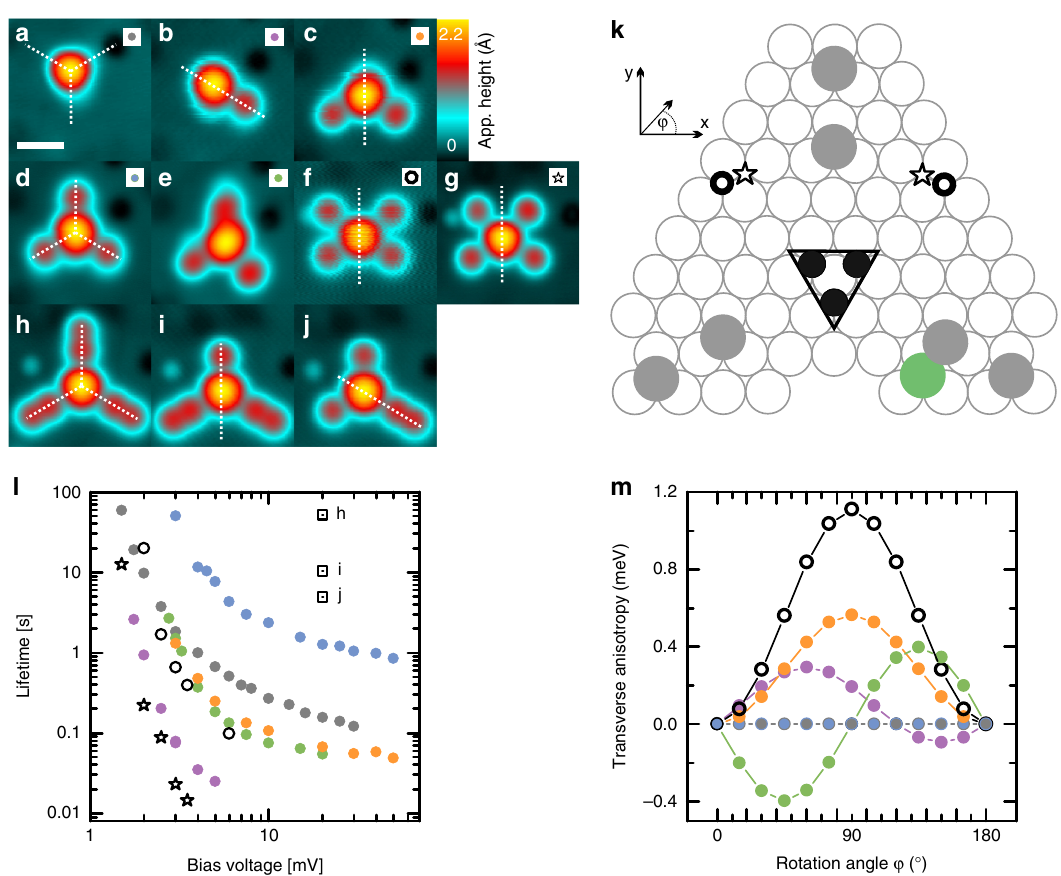
Fig. 4 Magnetic stability of multisatellite complexes. a – j Constant current images of the investigated complexes (the scale bar has a length of 1 nm). For ( b – d ) the distance between satellite atom and closest trimer atom is d = 0.8 nm. k The corresponding adsorption sites of the complexes shown in ( a – j ). l Bias dependence of the lifetimes measured on the trimer of the structures marked in ( a – j ) ( I = 750 pA B = 0 T and T = 300 mK, colors/symbols are given in a – j ). m Effective magnetic anisotropy energy of the spin system in dependence of a collinear rotation of the trimer and adatom spins in the sample surface (colors/symbols are given in a – j , 0° parallel to x -axis with the coordinates indicated in k